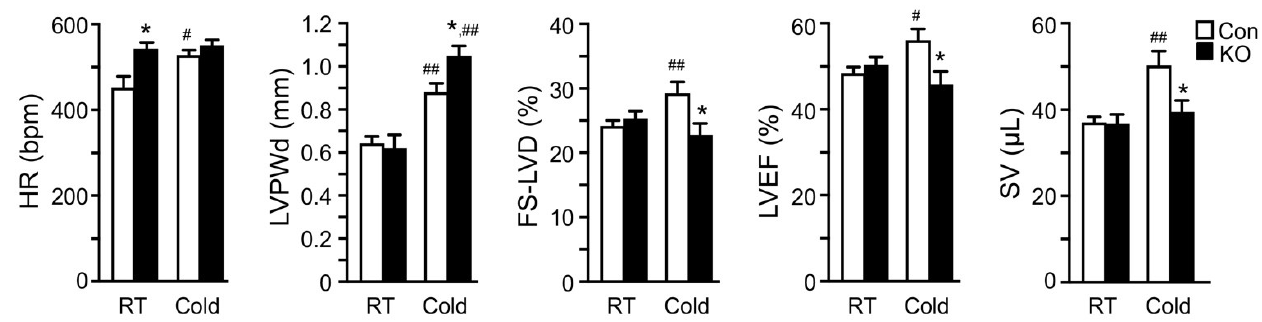
Figure 4. Deletion of adipose CGI-58 depresses cardiac responses to cold stress in chow-fed mice. Echocardiography analysis of cardiac structural and functional changes in 41–44-week-old chow-fed mice after cold acclimation (2 °C/day reduction in housing temperatures) for 7 days followed by housing at 6 °C for 26 days before analysis ( n = 6–9/group). * p < 0.05 vs. genotype; # p < 0.05 and ## p < 0.01 vs. housing temperature by two-tailed unpaired Student’s t -test. HR, heart rate; LVPWd, left ventricular posterior wall thickness at end diastole; FS-LVD, left ventricular fractional shortening; LVEF, left ventricular ejection fraction; SV, stroke volume.